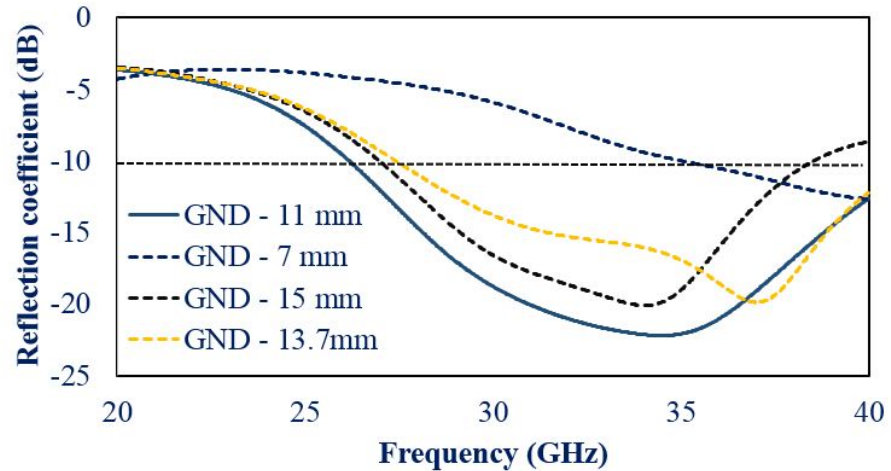
Figure 2. Reflection coefficient values for the various ground plane